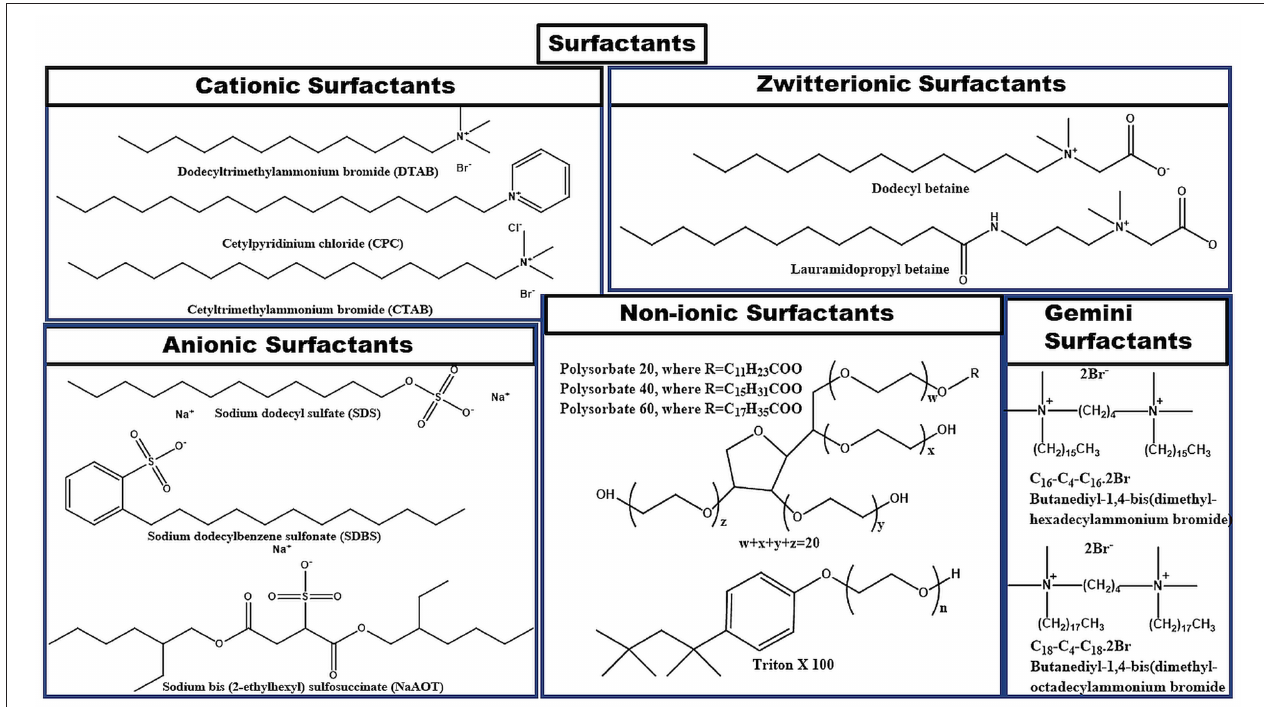
FIGURE 4 | Examples of various types of